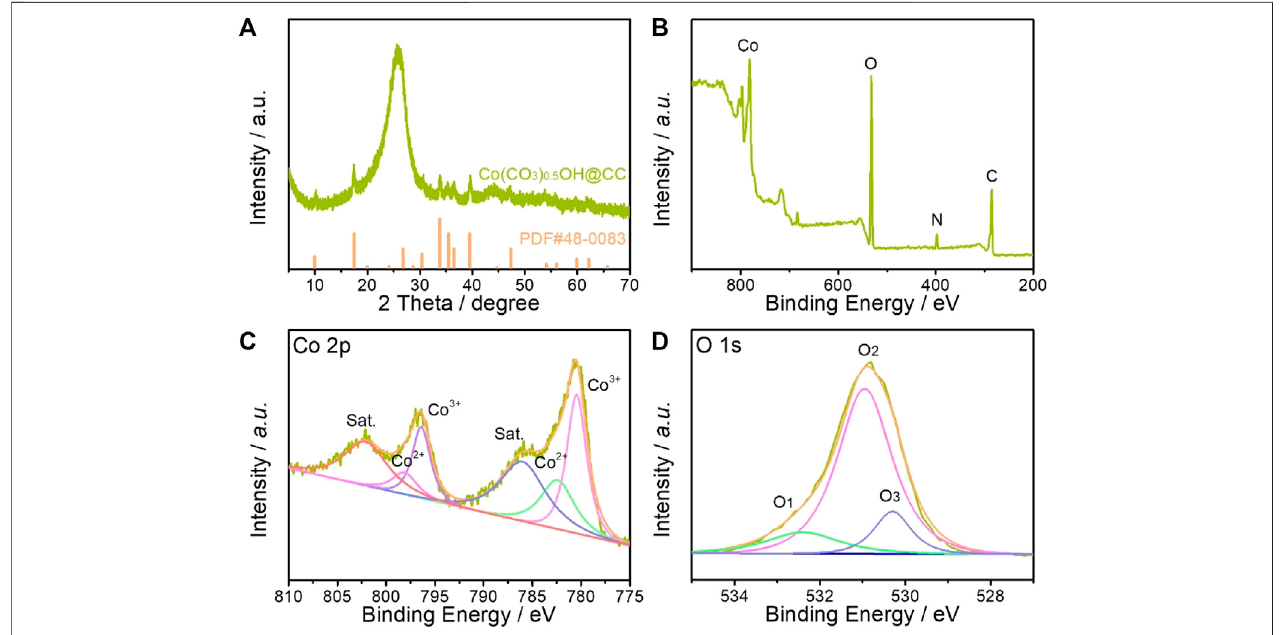
FIGURE 2 | (A) XRD pattern of Co(CO 3 ) 0.5 OH@CC nanoarrays; (B) Full XPS spectrum of Co(CO 3 ) 0.5 OH @CC nanoarrays; High-resolution (C) Co 2p and (D) O 1s XPS spectra.